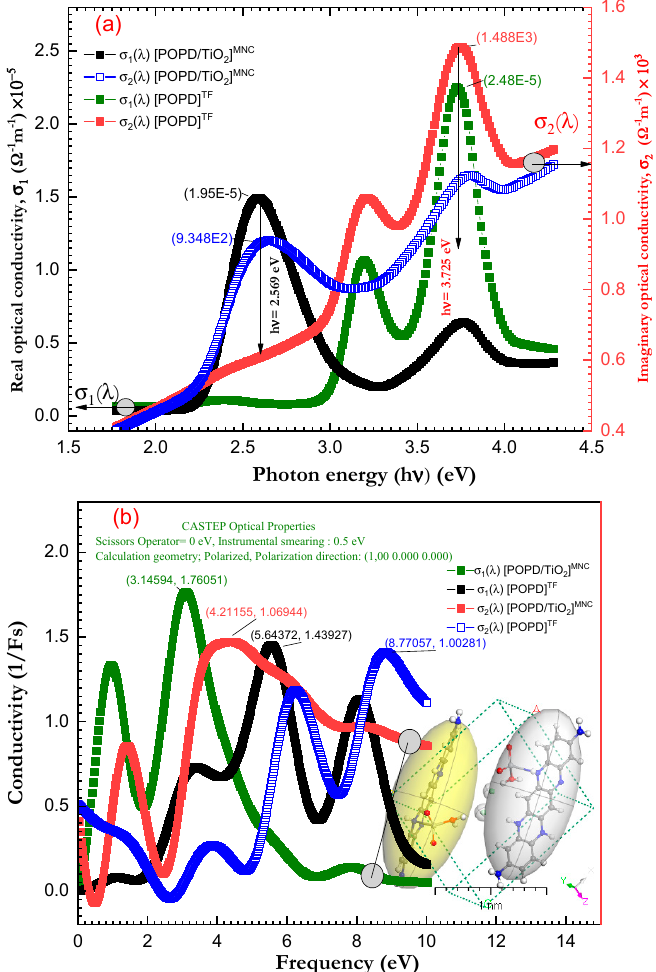
Figure 11. ( a ) The real ( σ 1 ) and imaginary conductivity ( σ 2 ), ( b ) ( σ 1 ), and ( σ 2 ) DFT simulation using CASTEP for [PoPDA] TF and [PoPDA/TiO 2 ] MNC.